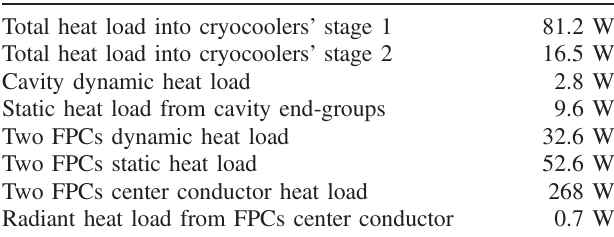
TABLE III. Summary of the cryomodule heat loads. Total heat load into cryocoolers ’ stage 1